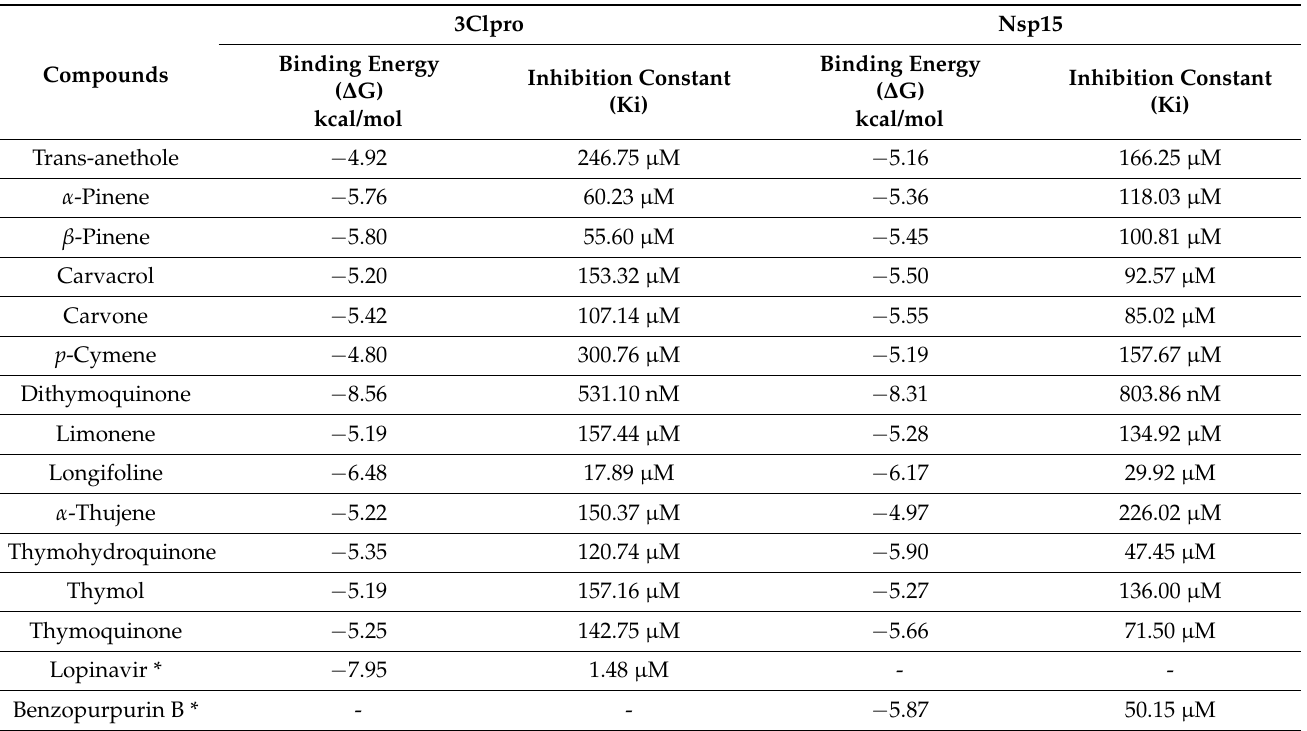
Table 1. Molecular docking results of ‘SARS CoV-2 main proteinase (3CLpro)’ and ‘SARS CoV-2 non-structural protein 15 (NSP15)’ interaction with active components of Nigella sativa and control compounds.